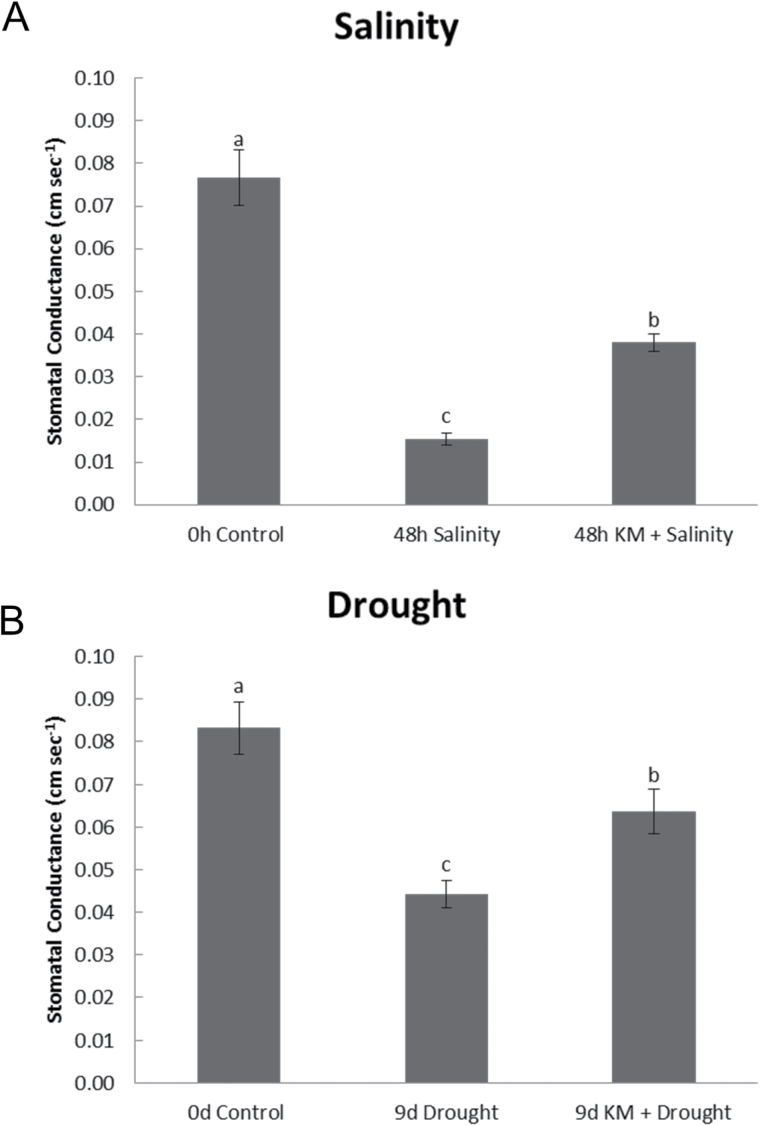
Leaf stomatal conductance in leaves of (A) salinity-stressed and (B) drought‐stressed M. truncatula plants in the absence or presence of KM pre‐treatment (KM 10‐8M).